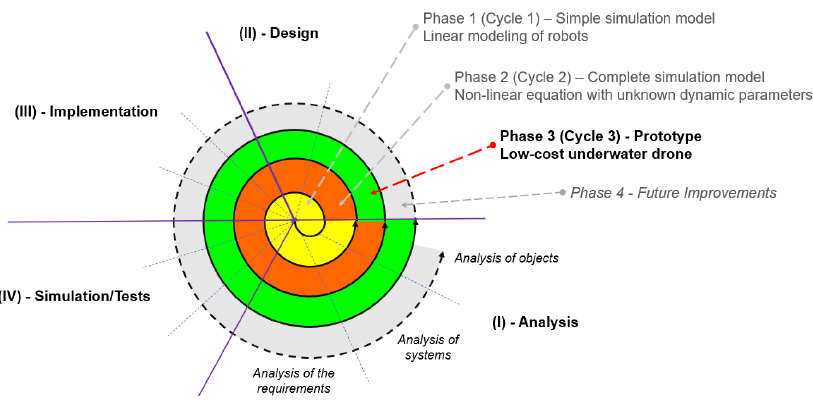
Figure 4. A complete diagram of the control and observation components of the low-cost underwater drone i .